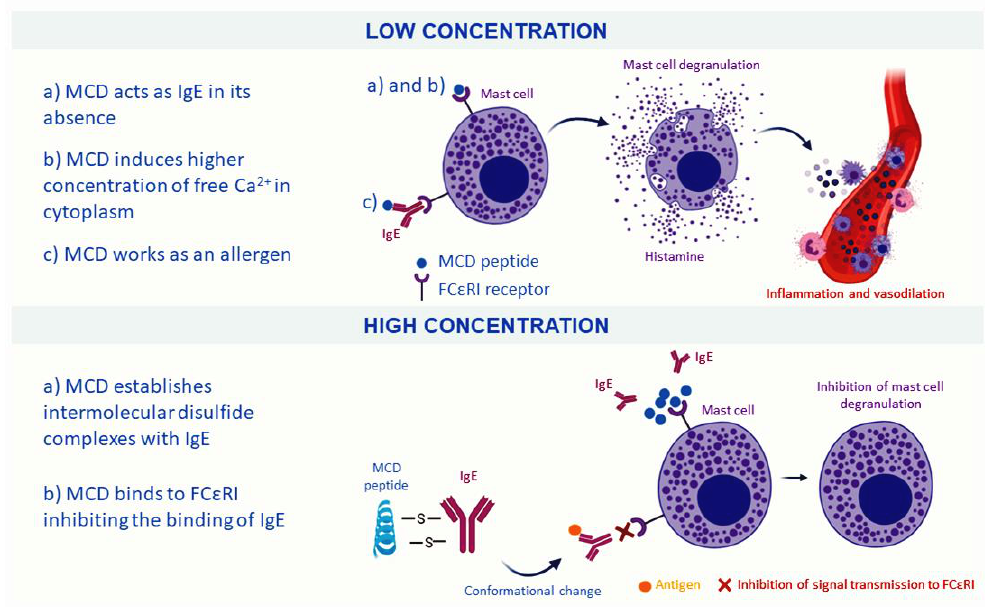
Figure 3. Different effects of Mast Cell-Degranulating (MCD) peptide when it is present in low or high concentration. In a low concentration, MCD induces mast cell degranulation and the release of histamine, resulting in inflammation processes. In a high concentration, MCD inhibits mast cell degranulation and therefore, exerts anti-inflammatory effects.